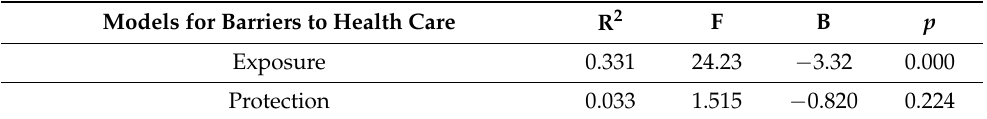
Table 2. Regression analysis to determine the relationship between exposure to earthquakes and barriers to health care services ( n =